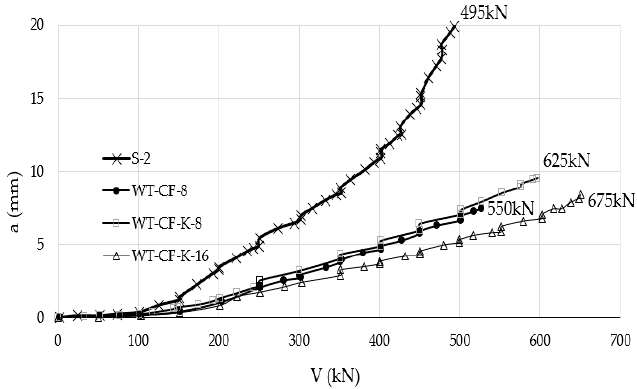
Figure 11. Load–deflection relationship for the control specimen (s), specimen with 8 CFRP strips specimen (WT-CF-8), specimen with 8-CFRP strips and anchor bolts (WT-CF-K-8), specimen with 8-CFRPs in double layers with anchor bolts [35].